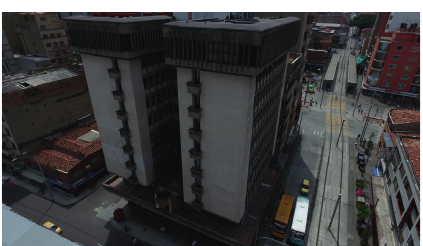
Figure 4: General view of the Beneficencia de Antioquia